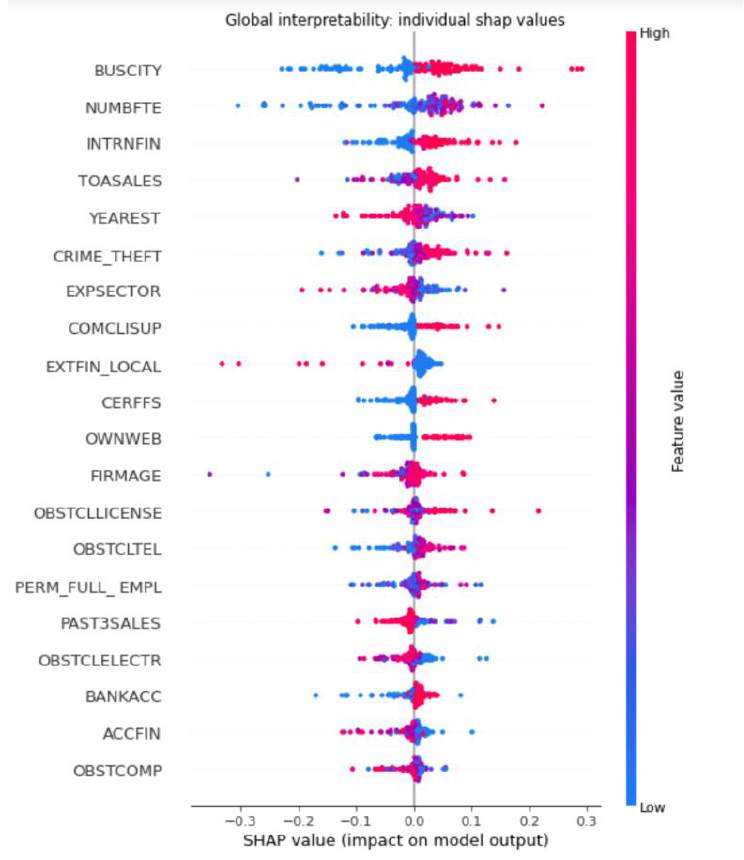
Figure 2: Important of the features using SHAP Values